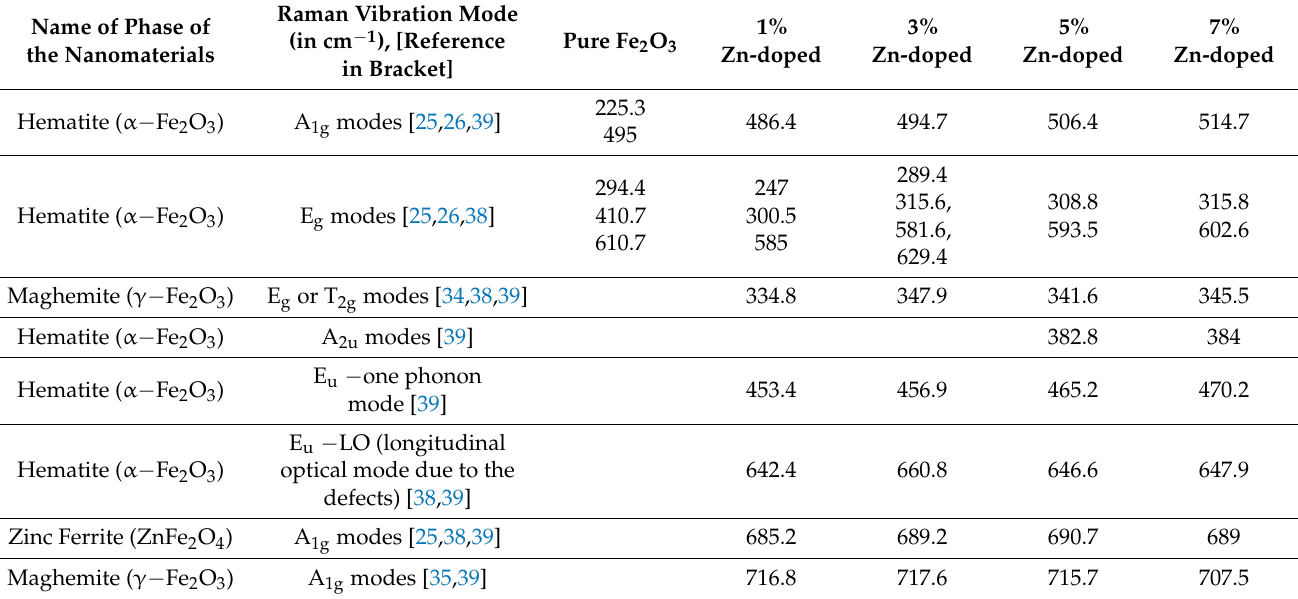
Table 2. Raman vibrational modes in pure Fe 2 O 3 and 1 to 7 % Zn − doped samples